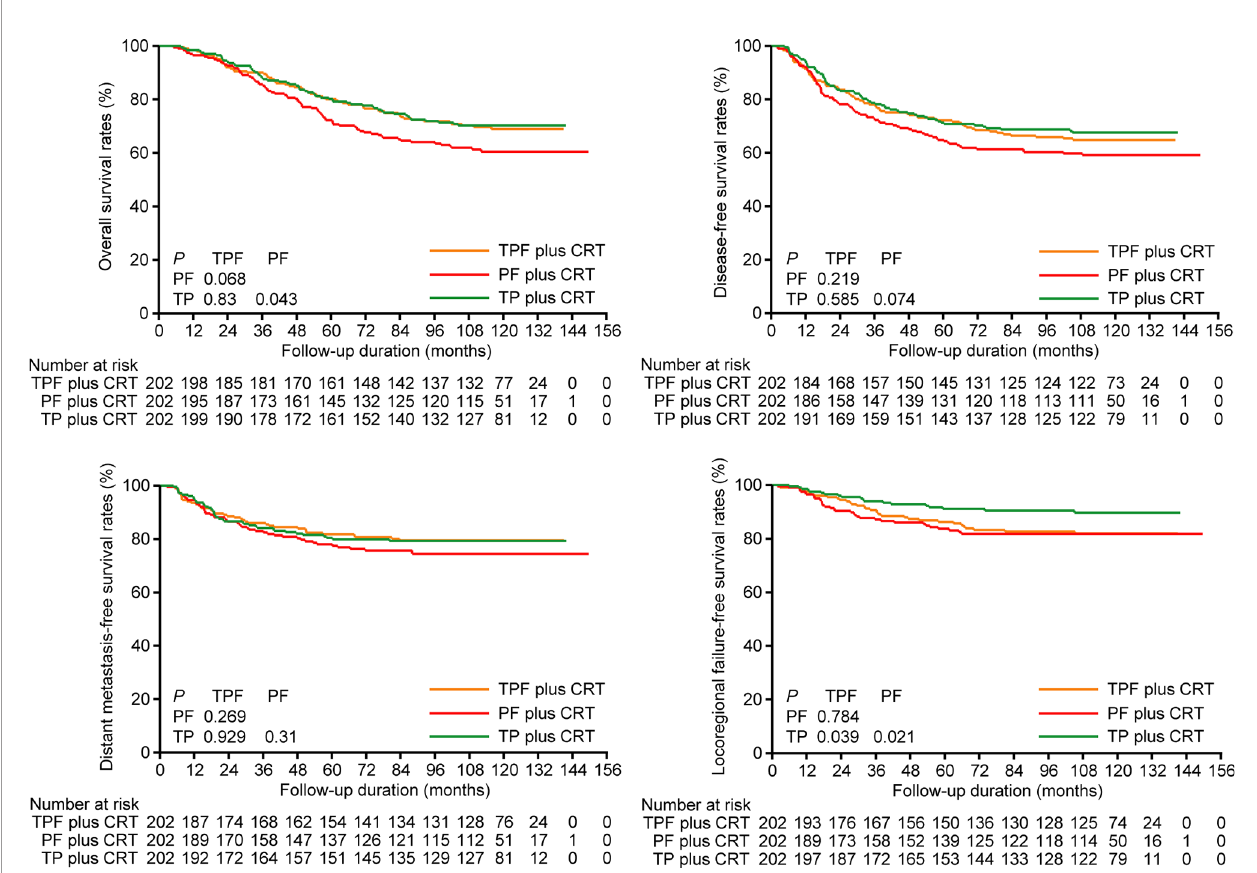
FIGURE 1 | Kaplan-Meier overall survival, disease-free survival, distant metastasis-free survival, and locoregional failure-free survival curves of patients receiving induction TPF, PF, and TP plus CRT in the 202 pairs selected by propensity score matching. TPF, docetaxel plus cisplatin and fl uorouracil; PF, cisplatin plus fl uorouracil; TP, docetaxel plus